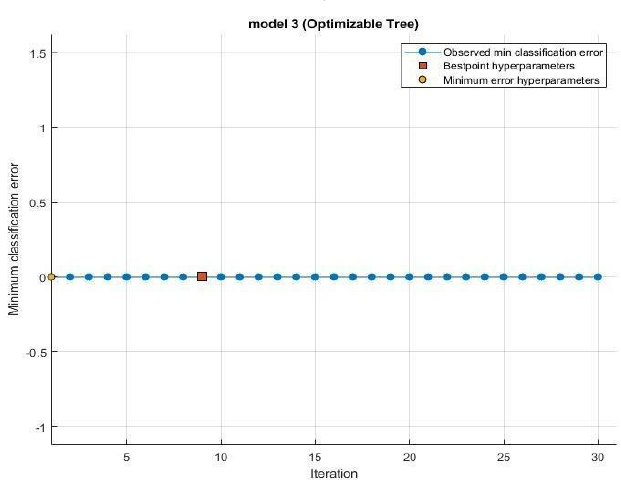
Fig. 11. ARP MitM minimum classification error of random search based optimized